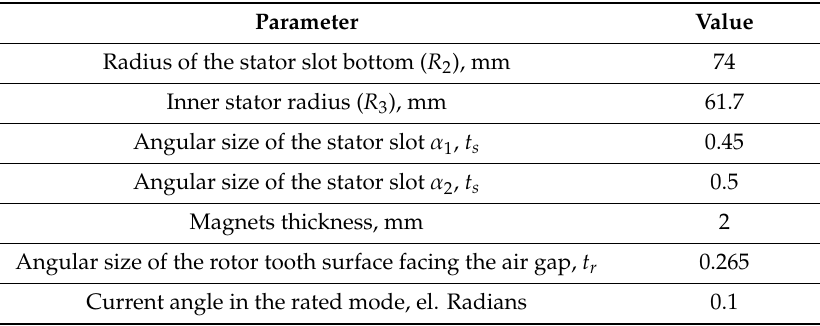
Table 6. The varied FSG parameters during the